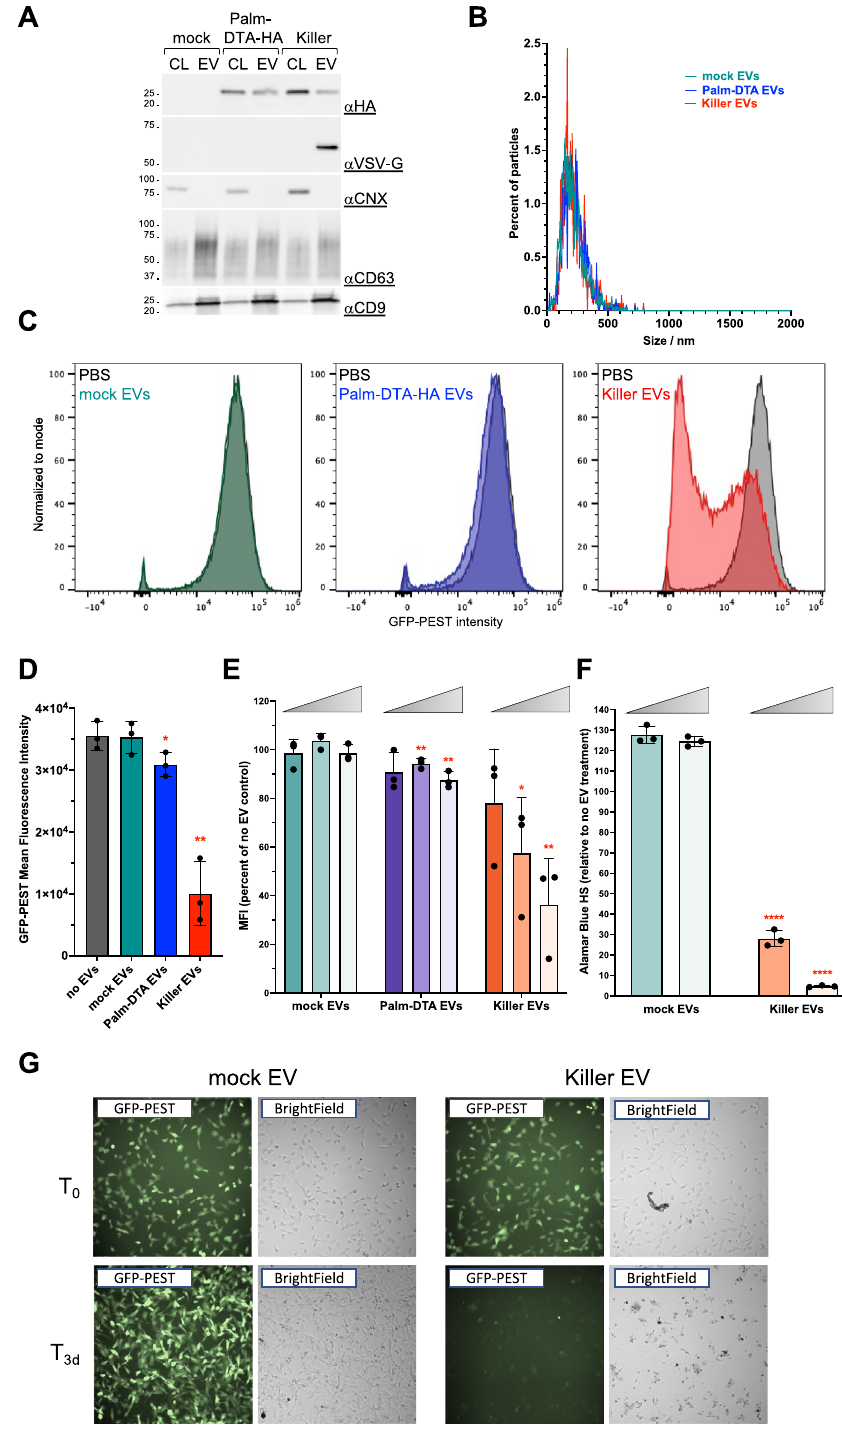
Figure 3. Killer EVs are potent in vitro. ( A ) Western blot characterization of EVs generated from DPH2KD cells transfected with plasmids encoding either Palm-DTA-HA, Palm-DTA-HA + VSV-G (Killer EVs), or a mock plasmid. The same amount of protein was loaded for each sample. ( B ) Particle metrics obtained for the EVs in A. ( C ) 100 µg/mL of the indicated EVs (or DPBS) were incubated for 24 h on GFP-PEST-expressing HT1080 cells. After incubation, green fluorescence was analyzed by FACS and data for each EV-treated sample was plotted against DPBS-treated cells. ( D ) Quantification of data obtained as in panel C. Plotted are the geometric mean of green fluorescence intensity (MFI) for each sample, each data point represents an independent experiment (including independent EV preparation). *: p < 0.1; **: p < 0.01. ( E ) 10, 20, or 50 µg/mL of the indicated EVs (or DPBS) were incubated for 24 h on GFP-PEST- expressing HT1080 cells. After incubation, cells were analyzed by FACS and the geometric mean of green fluorescence intensity for each sample was obtained and plotted as the percentage of the one obtained for DPBS-treated cells (set at 100%). Each data point represents an independent experiment (including independent EV preparation). *: p < 0.1; **: p < 0.01. ( F ) A cell viability assay was performed on GFP-PEST-expressing HT1080 cells incubated with the indicated EVs (20 or 50 µg/mL) for 3 days. ****: p < 0.0001. ( G ) Microscopic observation of GFP-PEST-expressing HT1080 acceptor incubated with 100 µg/mL Killer EVs indicates a total loss of cells after 3